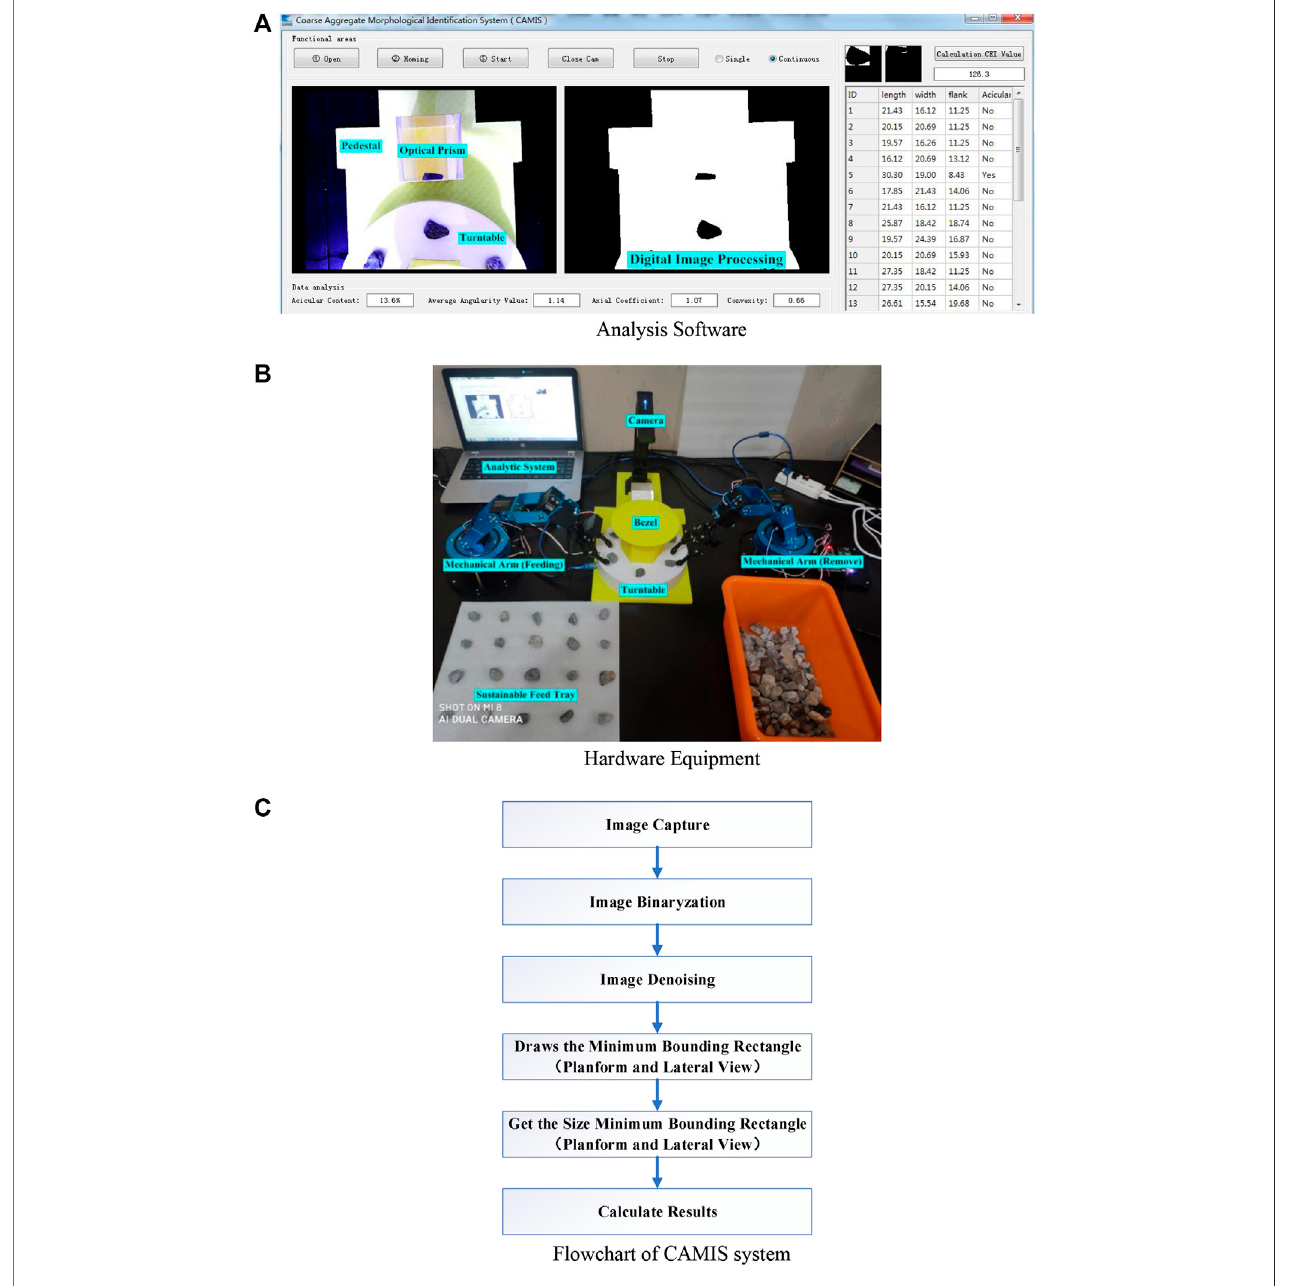
FIGURE 1 | Coarse aggregate morphological identi fi cation system. (A) Analysis software. (B) Hardware equipment. (C) Flowchart of CAMIS system.